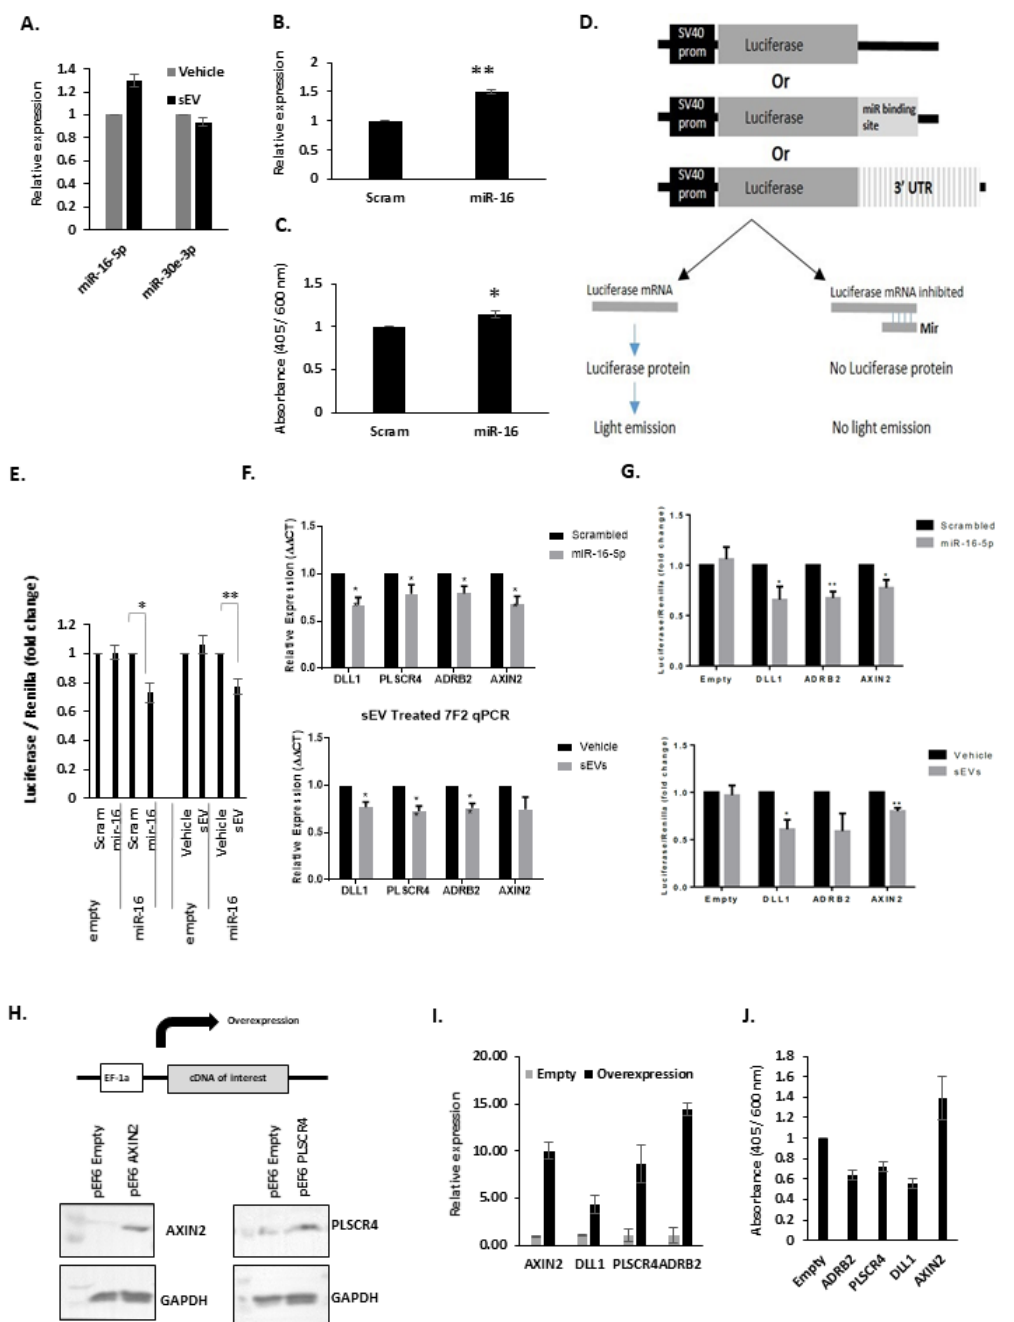
Figure 6. The effects of miR-16 in 7F2 osteoblasts . ( A ), Q-PCR analysis of miR-16 and miR-30 expression in sEV treated 7F2 cells. Data is normalised to U18 small nuclear RNA. ( B ), Q-PCR analysis of miR-16 expression in 7F2 cells transfected with either scrambled oligo or miR-16 mimic (5 pmol). Data is normalised to U18 small nuclear RNA. ( C ), Alizarin red mineralisation assay on 7F2 cells transfected with either scrambled oligo or miR-16 mimic (5 pmol). Graph shows alizarin red absorbance (405 nm) normalised to a post stain crystal violet stain (600 nm) for cell number. ( D ), schematic diagram of the luciferase empty, miR-reporter or UTR reporter plasmid constructs, and the downstream effects of miRs on their activity. ( E ), Luciferase assays on 7F2 cells transfected with either empty or miR16 reporter luciferase constructs and either scrambled oligo or miR-16 mimic. Data is normalised to the internal constitutively expressed renilla luciferase activity. ( F ), Upper panel-Q-PCR analysis of the expression of the four miR-16 gene targets in 7F2 cells transfected with either scrambled or miR-16 mimic oligos. Lower panel-Q-PCR analysis of the expression of the four miR-16 gene targets in 7F2 cells treated with either sEVs or PBS control. Data is normalised to housekeeping genes -actin, GAPDH and RPL19. ( G ), Upper panel-Luciferase